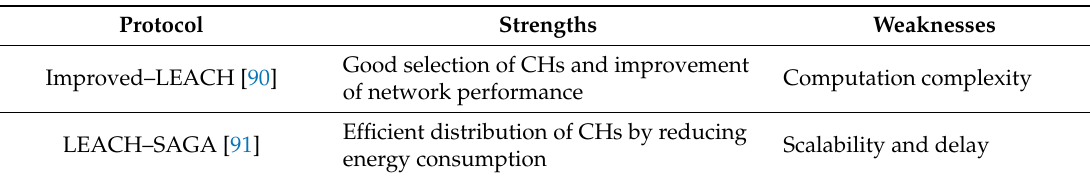
Table 6. Summary of distance-based CH selection